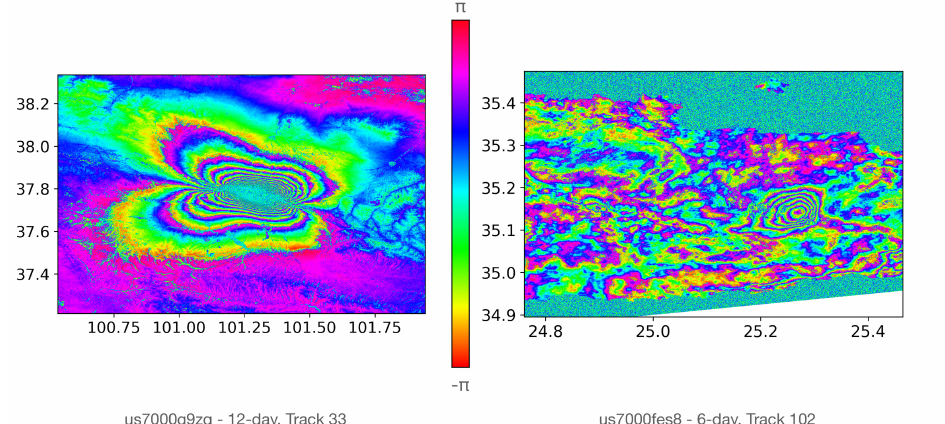
Figure 5. Example of wrapped phase data from our global InSAR product. ( Left ) Track 33 12-day interferogram of the M 6.6 northern Qinghai (USGS id: us7000g9zq) earthquake from 7 January 2022. ( Right ) Track 102 6-day interferogram of the M 6.0 Thrapsanon (USGS id: us7000fes8) earthquake from 27 September